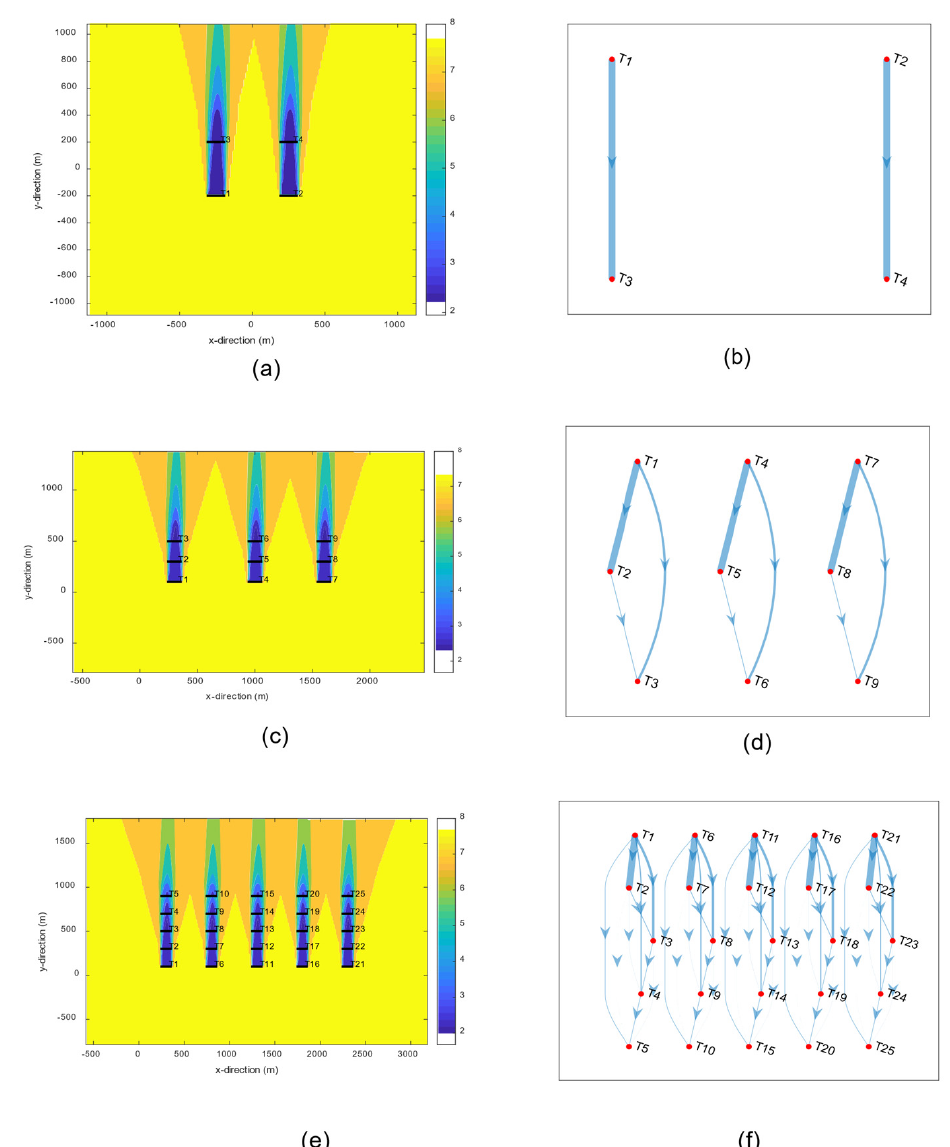
Figure 4. The original wake digraph G under different wind turbines ϕ = 90 ◦ : ( a ) 2 × 2 turbines wake field; ( b ) 2 × 2 turbines original wake digraph; ( c ) 3 × 3 turbines wake field; ( d ) 3 × 3 turbines original wake digraph; ( e ) 5 × 5 turbines wake field; ( f ) 5 × 5 turbines original wake digraph.